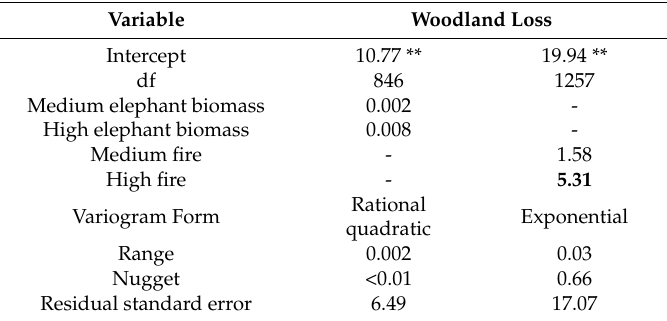
Table 3. Generalized least squares regression results.